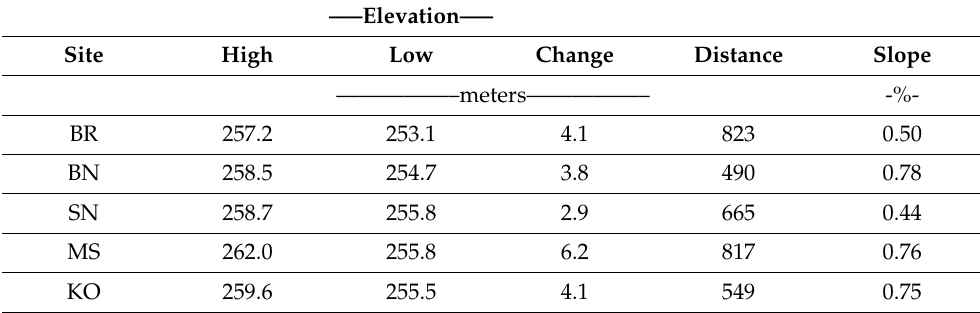
Table 2. Elevation and average slope of study